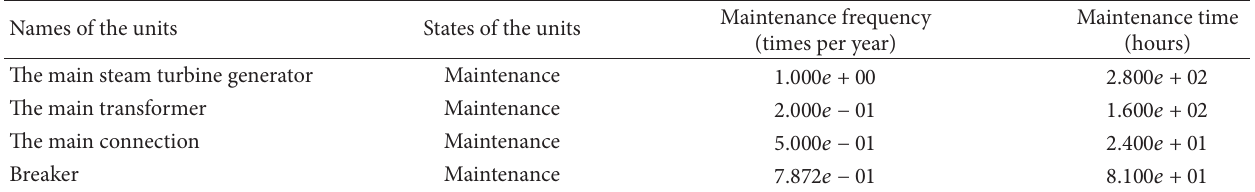
Table 3: The maintenance frequency and maintenance time of repairable components.